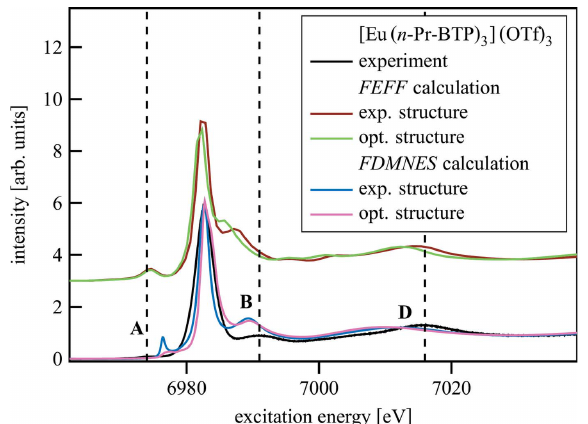
Figure 6 Calculations of [Eu( n -Pr-BTP) 3 ](OTf) 3 with FEFF and FDMNES with experimental and DFT optimized structures compared with the experi- mental spectrum.